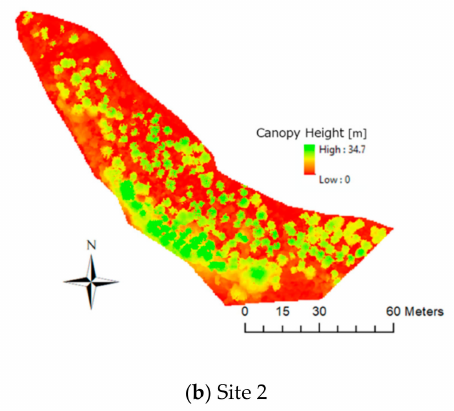
Figure 7. Estimated CHM.